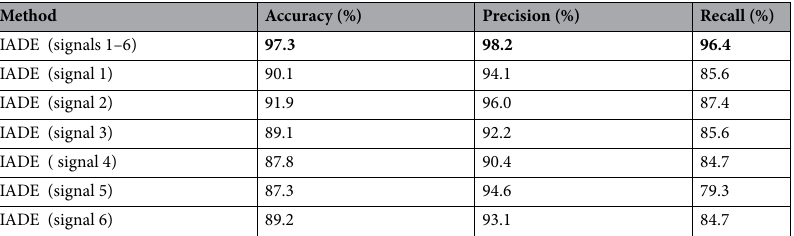
Table 1. IADE Results of our method, with six accelerometer images as input, with respect to the results from the single accelerometer data as input. Precision and recall use the retrofitted bridge category as the positive class and the normal bridge category as the negative class. Best results are reported in